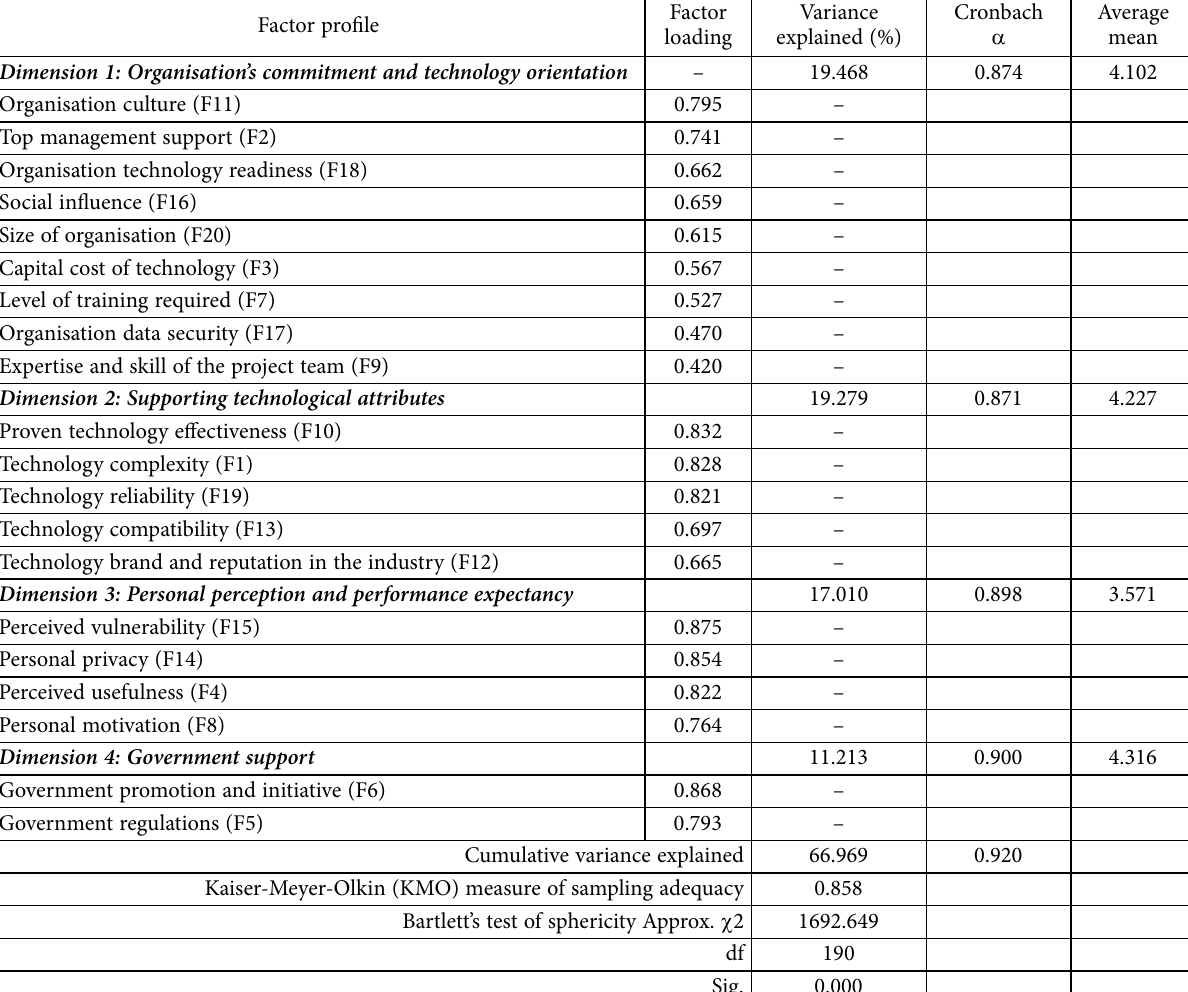
Table 5. Factor loading and variance